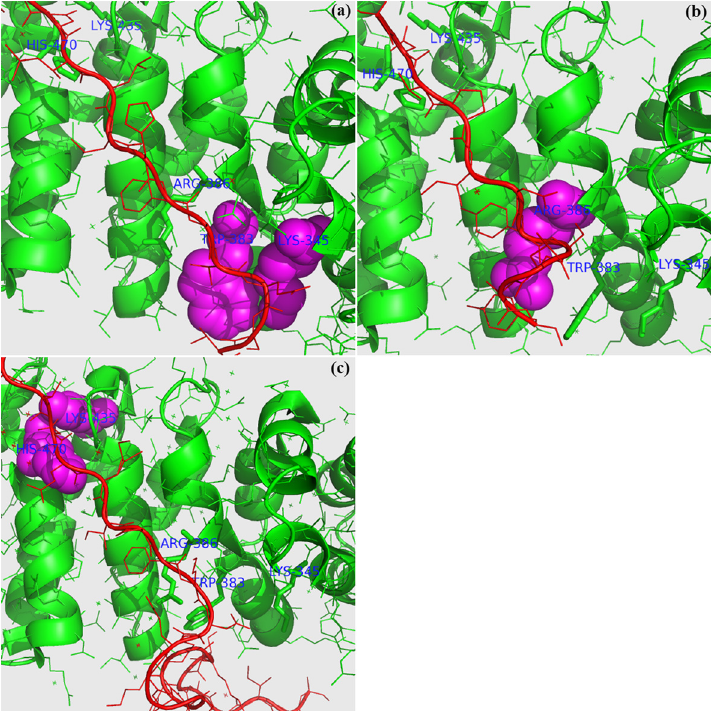
in (c)). There is an overlapping common area to the interfaces of these protein complexes; the chains in green are the same, but the binding partner proteins in red are different. The binding hot spots in Chain A (Lys-345 and Trp-383 in (a), Arg-386 in (b), and Lys-435 and His-470 (c)) are all in a ‘ spheres ’